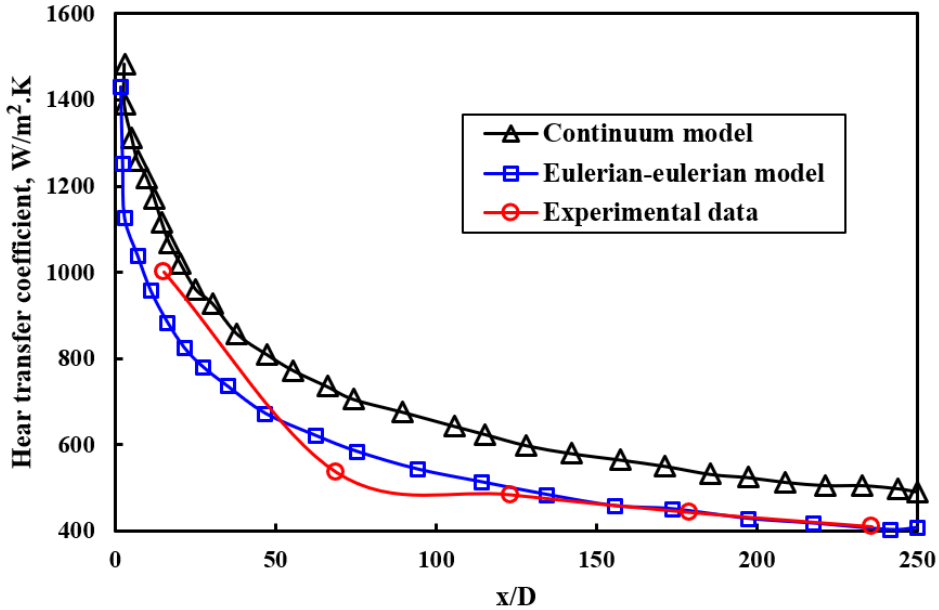
Figure 24. Comparison of two different numerical models (Eulerian vs. Continuum) for heat transfer coefficients with respect to experimental data ( R eD = 1505) (([C 4 mim][NTf 2 ] IL and 0.36 vol% Al 2 O 3 nanopartcles) [98]. Reproduced with permission from [Paul], [Int. J. Heat Mass Transf.]; published by [Elsevier], 2019.